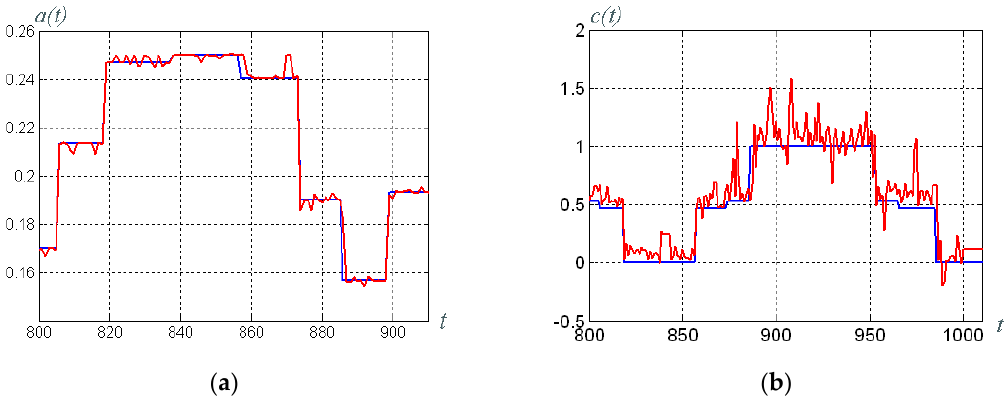
Figure 12. MATLAB / Simulink overall secure communication system block diagram with a two-channel synergetic observer. Here: block 1 is the useful signals source; block 2 is the transmitter with a chaotic generator; block 4 simulates errors in the communication channel; block 3 is the communication channel; and block 5 is the receiver (two-channel observer).